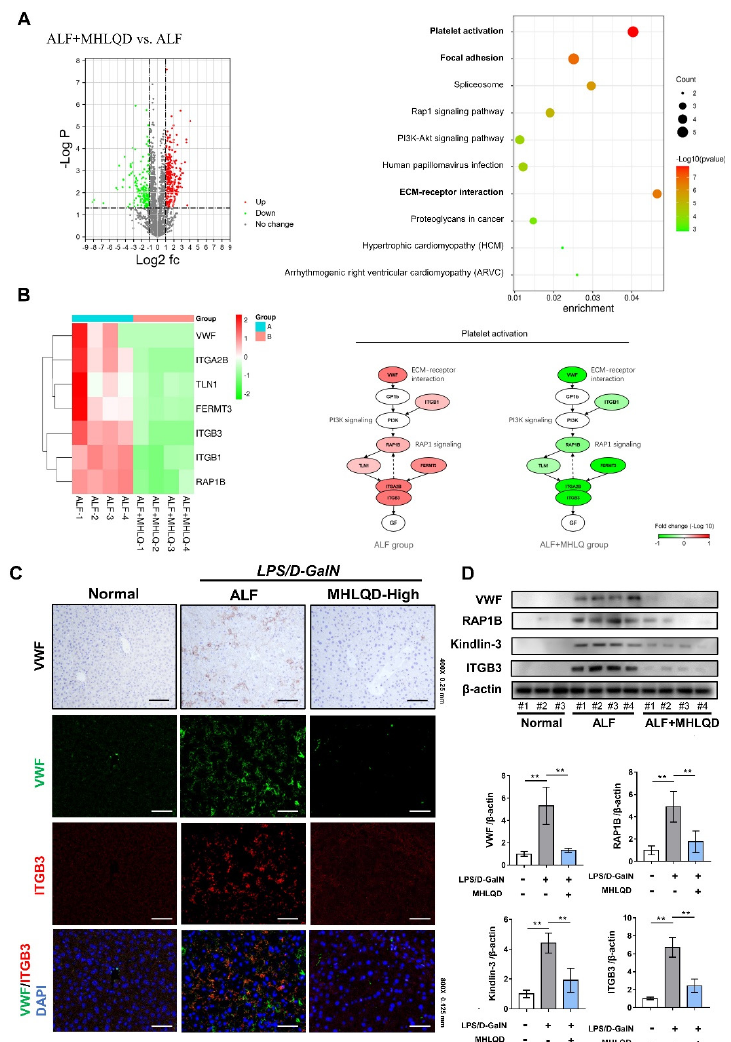
Figure 5. MHLQD inhibited VWF-induced platelet activation in ALF mice. The mice were intraperitoneally injected with D − GalN and LPS to establish the ALF model. MHLQD or PBS was orally administrated to mice 1.5 h before and 1.5 h after LPS/D − GalN injection. ( A ): KEGG enrichment analysis of top 10% DEPs between the ALF+MHLQD and the ALF group. ( B ): The heatmap of protein expression and the signal transduction schema of platelet activation signaling between the ALF+MHLQD and the ALF group. ( C ): The immunohistochemical staining of VWF in liver tissues (Scale bar: 0.25 mm) and the colocalization of VWF (Green) and ITGB3 (Red) (Scale bar: 0.125 mm). ( D ): VWF-induced platelet activation signal was detected by western blot. ** p < 0.01. Abbreviation: MHLQD: MaHuang-LianQiao-ChiXiaoDou decoction, VWF: von Willebrand factor, ALF: acute hepatic failure.